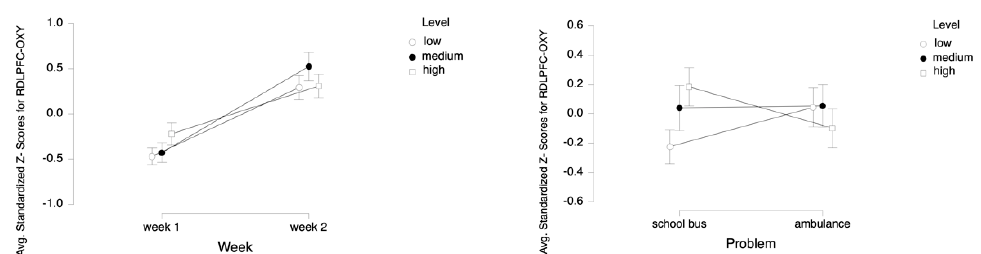
Figure 13. Line plots represent interaction effects of Level and Week (left) and Level and Problem (right) on average stan- dardized z scores for oxygenation for right dorsolateral prefrontal cortex (Z-RDLPFC-OXY) with the error bars representing the standard error of the mean statistic. Differences in average oxygenation for Z-RDLPFC are represented across low, medium, and high cognitive load tasks for Week 1 and Week 2 and for School Bus and Ambulance problem scenarios.